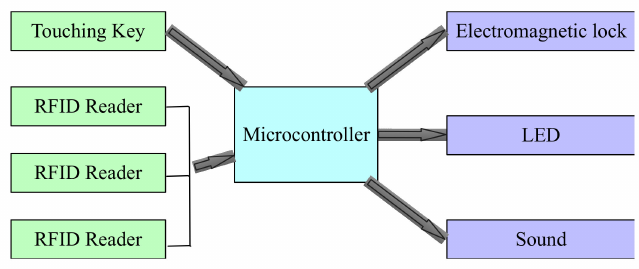
Figure 10. The local controller